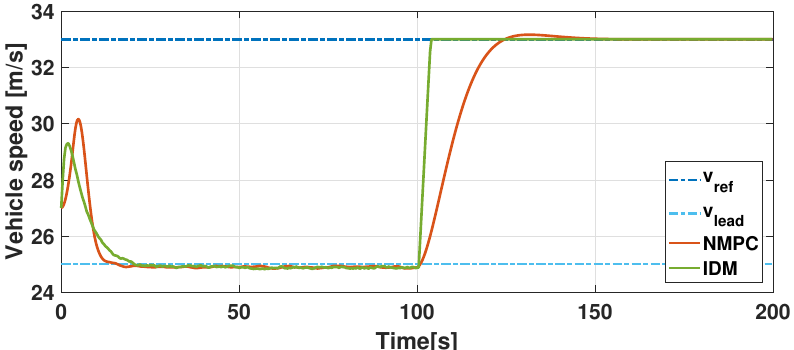
Figure 7. Single lane changing scenario . Performance of the proposed solution and comparison analysis w.r.t. IDM solution. Time-history of the longitudinal Ego vehicle speed v ( t ) .